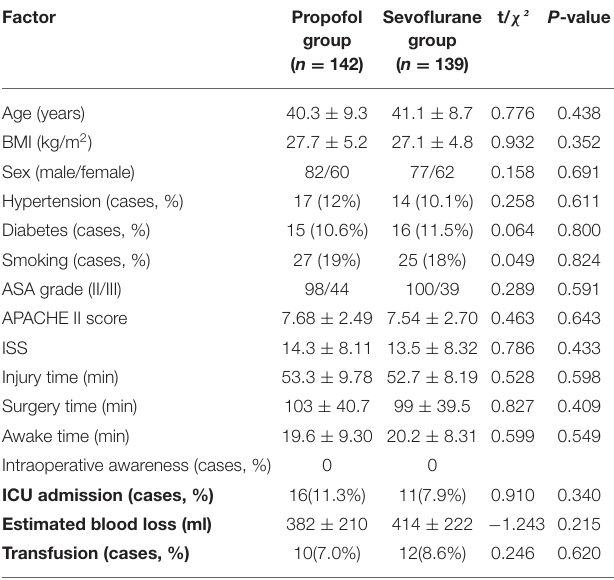
TABLE 3 | CAPS-5 scores and the incidence of adverse events in the two